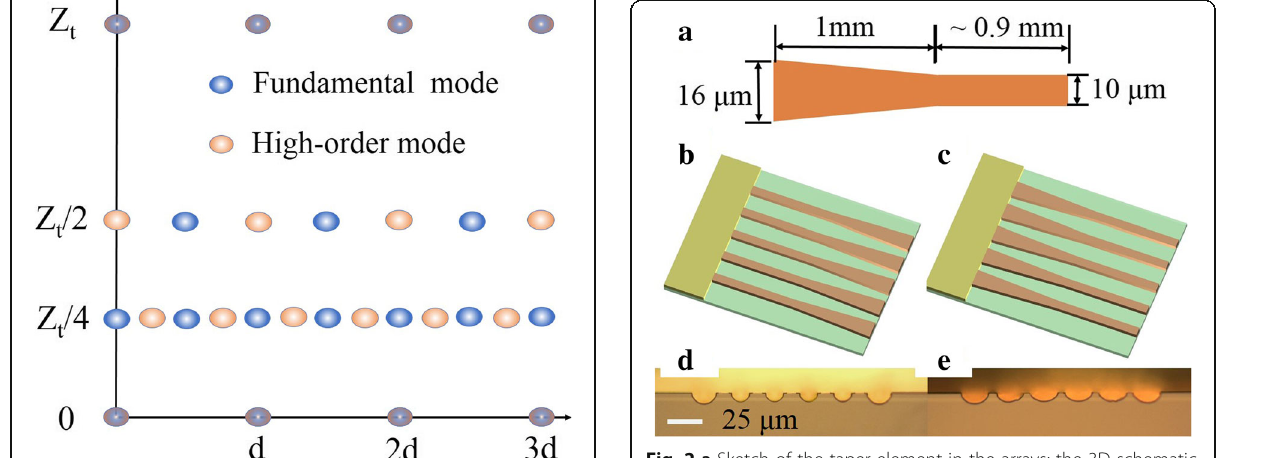
Fig. 2 a Sketch of the taper element in the arrays; the 3D schematic of the arrays with b straight-end connected to Talbot cavity and c taper-end connected to Talbot cavity, corresponding to the front facet microscope images of d and